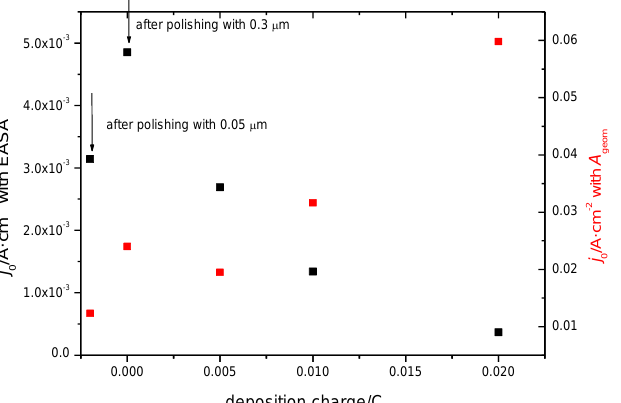
Figure 6. The j 0 calculated with respect to the EASA (black symbols, left) and geometric surface area (red symbols, right).